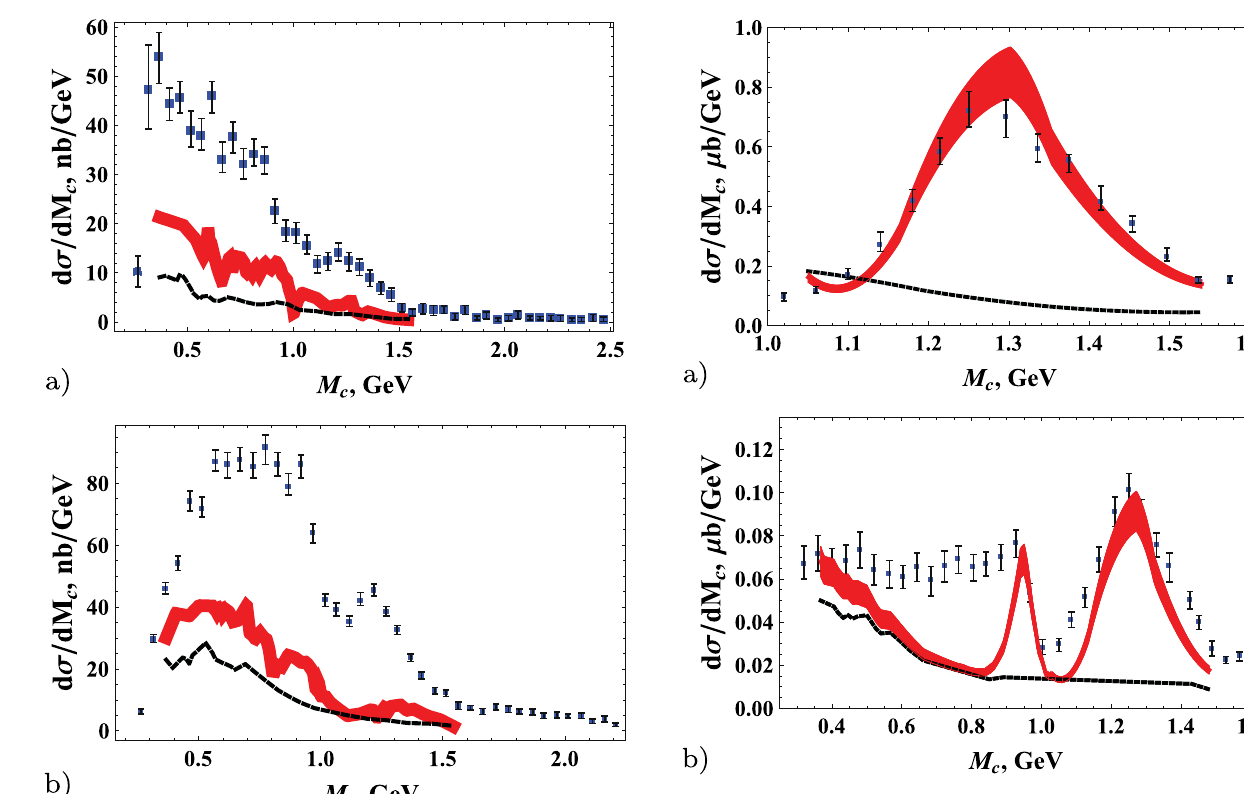
Fig. 10 Data on the process p + ¯ p → p + π + + π − + ¯ p (CDF col- √ s = 1 . 96 TeV: a | η π | < 1 . 3, | y ππ | < 1, laboration [27,28]) at Fig. 9 Data on the process p + p → p + π + + π − + p (ISR and √ p T ,π > 0 . 4 GeV; b | η π | < 1 . 3, | y ππ | < 1, p T ,π > 0 . 4 GeV, s = 63 GeV, | y π | < 1, ABCDHW collaborations [19,20]): a at √ p T ,ππ > 1 GeV. Curves correspond to Λ π = 1 . 2 GeV in the off- ξ > 0 . 9; b at s = 62 GeV, | y π | < 1 . 5, ξ p > 0 . 9. Curves cor- p shell pion form factor (11) and couplings from (14). Solid upper curves respond to Λ π = 1 . 2 GeV in the off-shell pion form factor (11) and correspond to the sum of all amplitudes, and dashed lower curves repre- couplings from (14). Solid upper curves correspond to the sum of all sent the continuum contribution. Fluctuations in solid curves are due to amplitudes, and dashed lower curves represent the continuum contribu- thecomplexMonteCarlointegrationprocess,andtheycanbesmoothed tion. Fluctuations in solid curves are due to the complex Monte Carlo by increasing the integration accuracy. The thickness of the solid curves integration process, and they can be smoothed by increasing the inte- corresponds to the errors of Monte Carlo calculations. Additional inter- gration accuracy. The thickness of the solid curves corresponds to the polation was used between calculated points for errors of Monte Carlo calculations. Additional interpolation was used between calculated points for smoothing